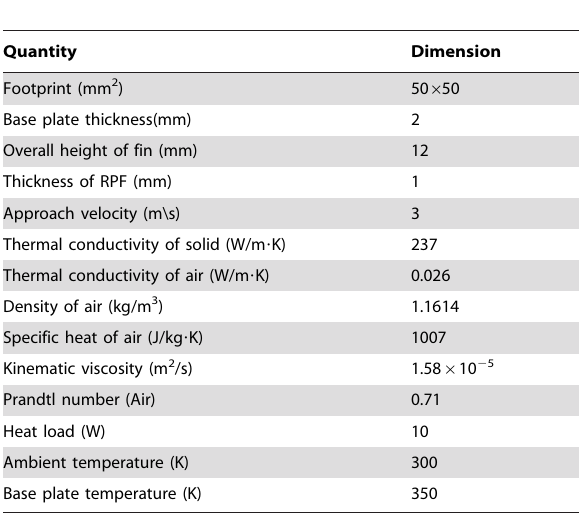
Table 2. Dimensions used to determine the performance of fin geometry.